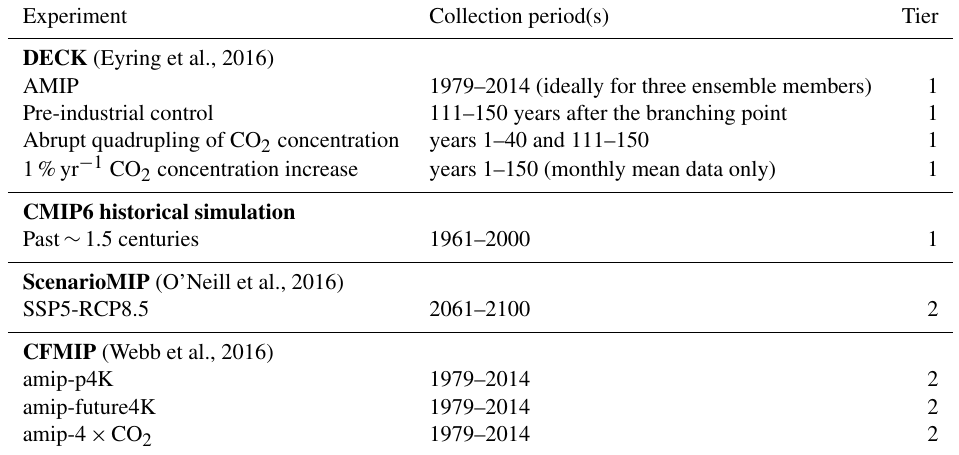
Table 6. Experiments and integration years for which the DynVarMIP diagnostics are requested. In bold: name of experiment MIP or group. Experiment Collection period(s) Tier DECK (Eyring et al., 2016) AMIP 1979–2014 (ideally for three ensemble members) 1 Pre-industrial control 111–150 years after the branching point 1 Abrupt quadrupling of CO 2 concentration years 1–40 and 111–150 1 CMIP6 historical